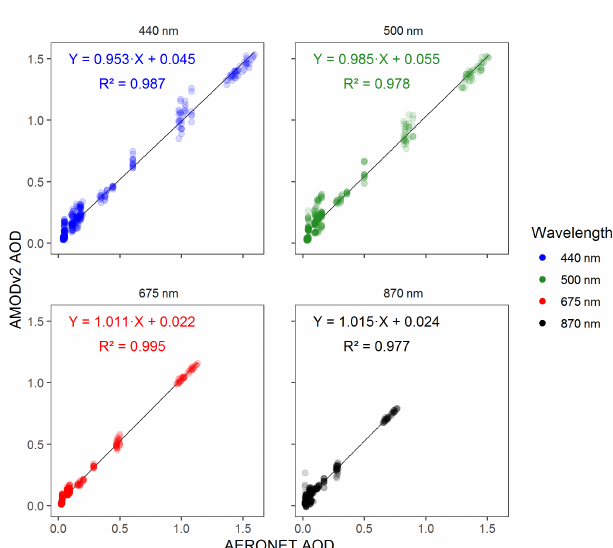
Figure 3. AERONET (MAXAR-FUTON site in Fort Lupton, Col- orado, USA) vs. AMODv2 AOD co-located comparison ( n = 426) results, with panels separated by wavelength. Lines of best fit were calculated via Deming regression analysis.